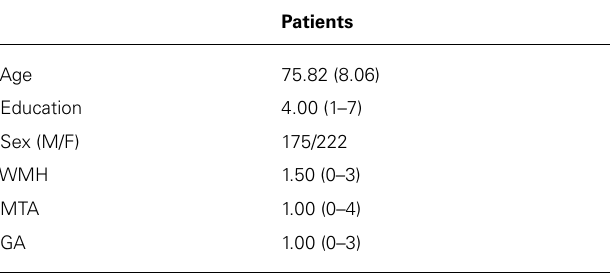
Table 1 | Characteristics of the